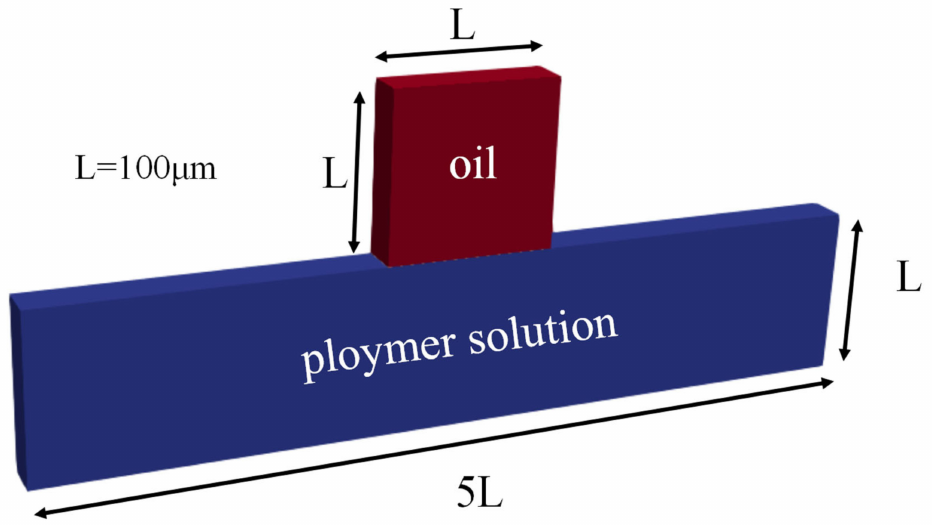
Figure 1. Physical model of the dead‑end capillary.